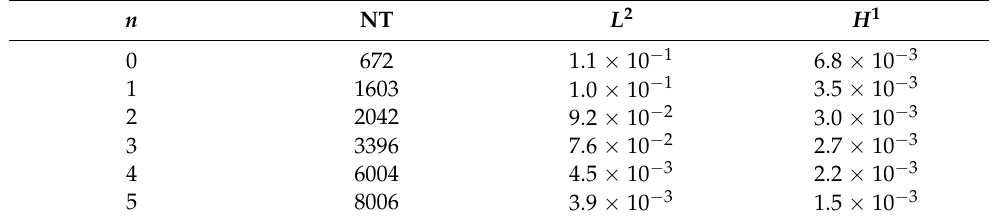
Table 7. Error in L 2 norm and H 1 seminorm for example 3 obtained with the residual-based error estimator.